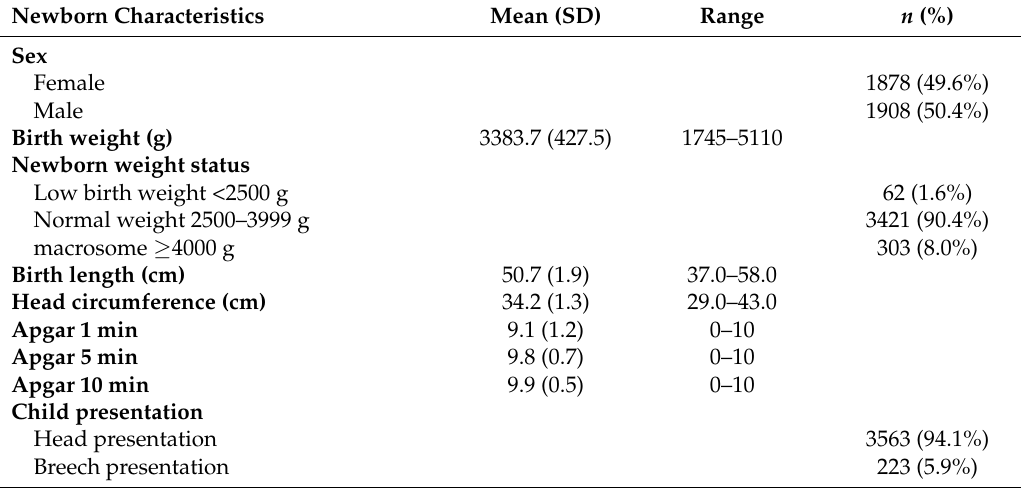
Table 2. Newborn sample characteristics, absolute and relative frequencies.